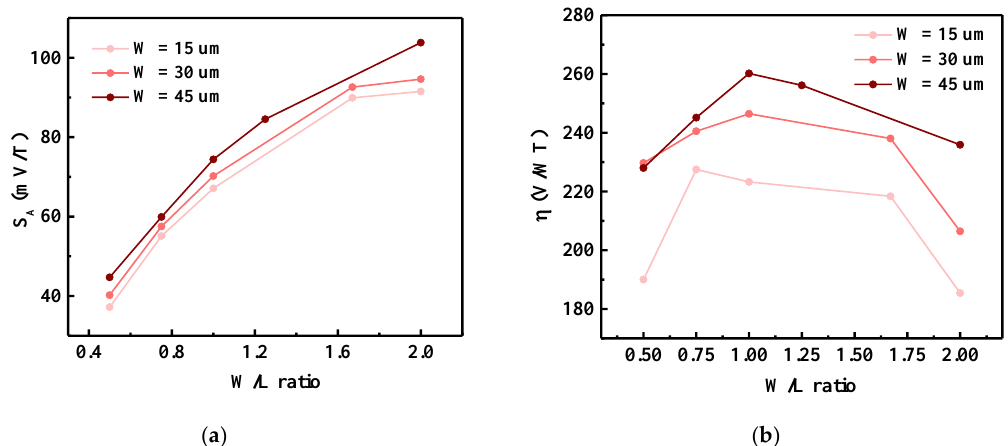
Figure 6. Simulated ( a ) absolute sensitivity ( S A ) and ( b ) efficiency factor ( η ) as a function of the W/L ratio for different sensor widths.